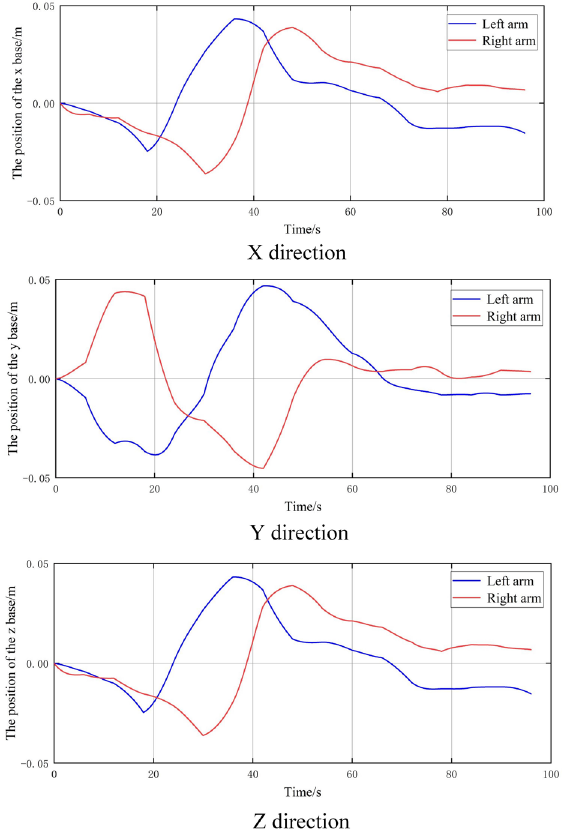
Figure 17. Deviation between actual position and ideal target position.